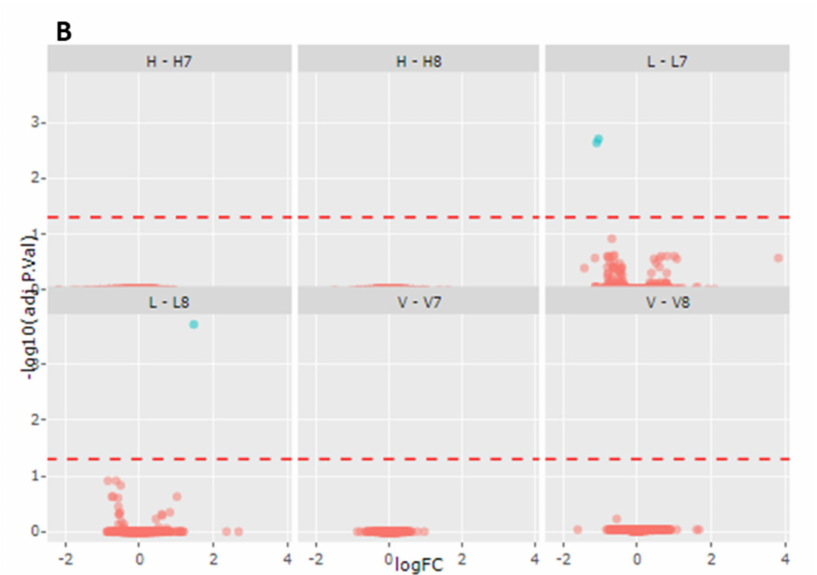
Figure 2. Volcano plots illustrating differently expressed proteins in fibroblasts of healthy controls ( n = 3), VLCADD ( n = 3) and LCHADD ( n = 3) under control conditions and after incubation either with C7 or C8. ( A ) Genotype effect. ( B ) Treatment effect. H: healthy controls; V: VLCADD; L: LCHADD. H7-V7-L7: healthy controls, VLCADD and LCHADD after incubation with C7. H8-V8-L8: healthy controls, VLCADD and LCHADD after incubation with C8.